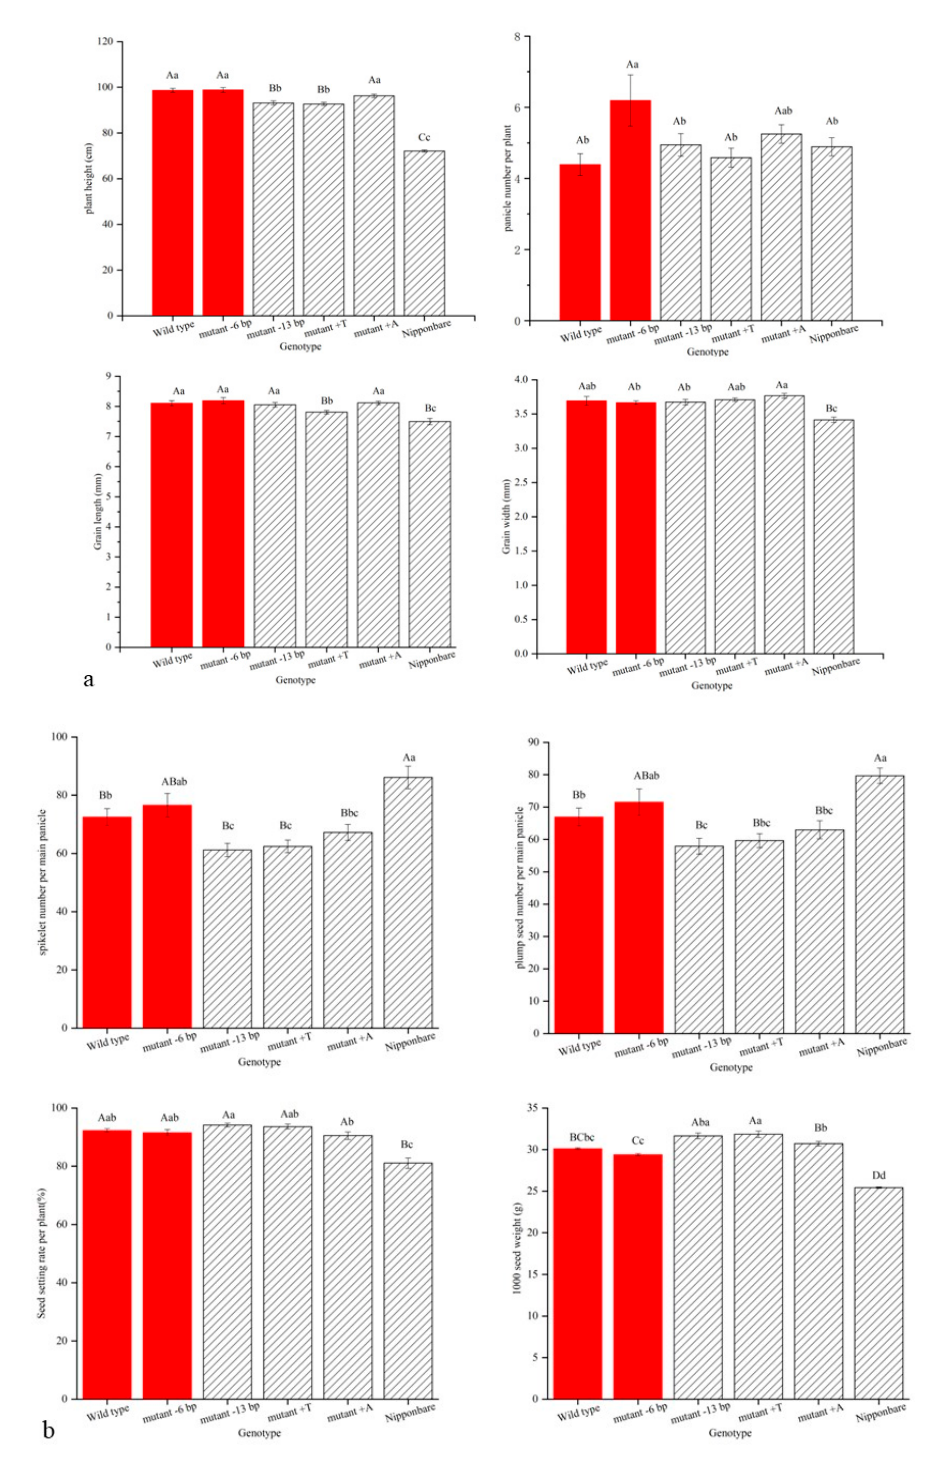
Figure 5. Phenotype traits of wild type and T3 mutant of weedy rice. Note: eight traits were measured including plant height, panicle number, grain length and width ( a ), seed setting rate per plant, spikelet number per main panicle, plump seed number per main panicle, and 1000-grain weight ( b ). Three-time replicates were carried out and for each replication, 12 plants were used. Wild type is Wrl-162. Mutants are Rc1-162-18, Rc1-162-1, Rc1-162-16, and Rc1-162-17. Wild type weedy rice and rice cultivar (Nipponbare) as control The vertical bars indicate standard error of the means.. Significance levels are indicated by letters (a, b, c) and letters (A, B, C) for p < 0.05 and p < 0.01, respectively.